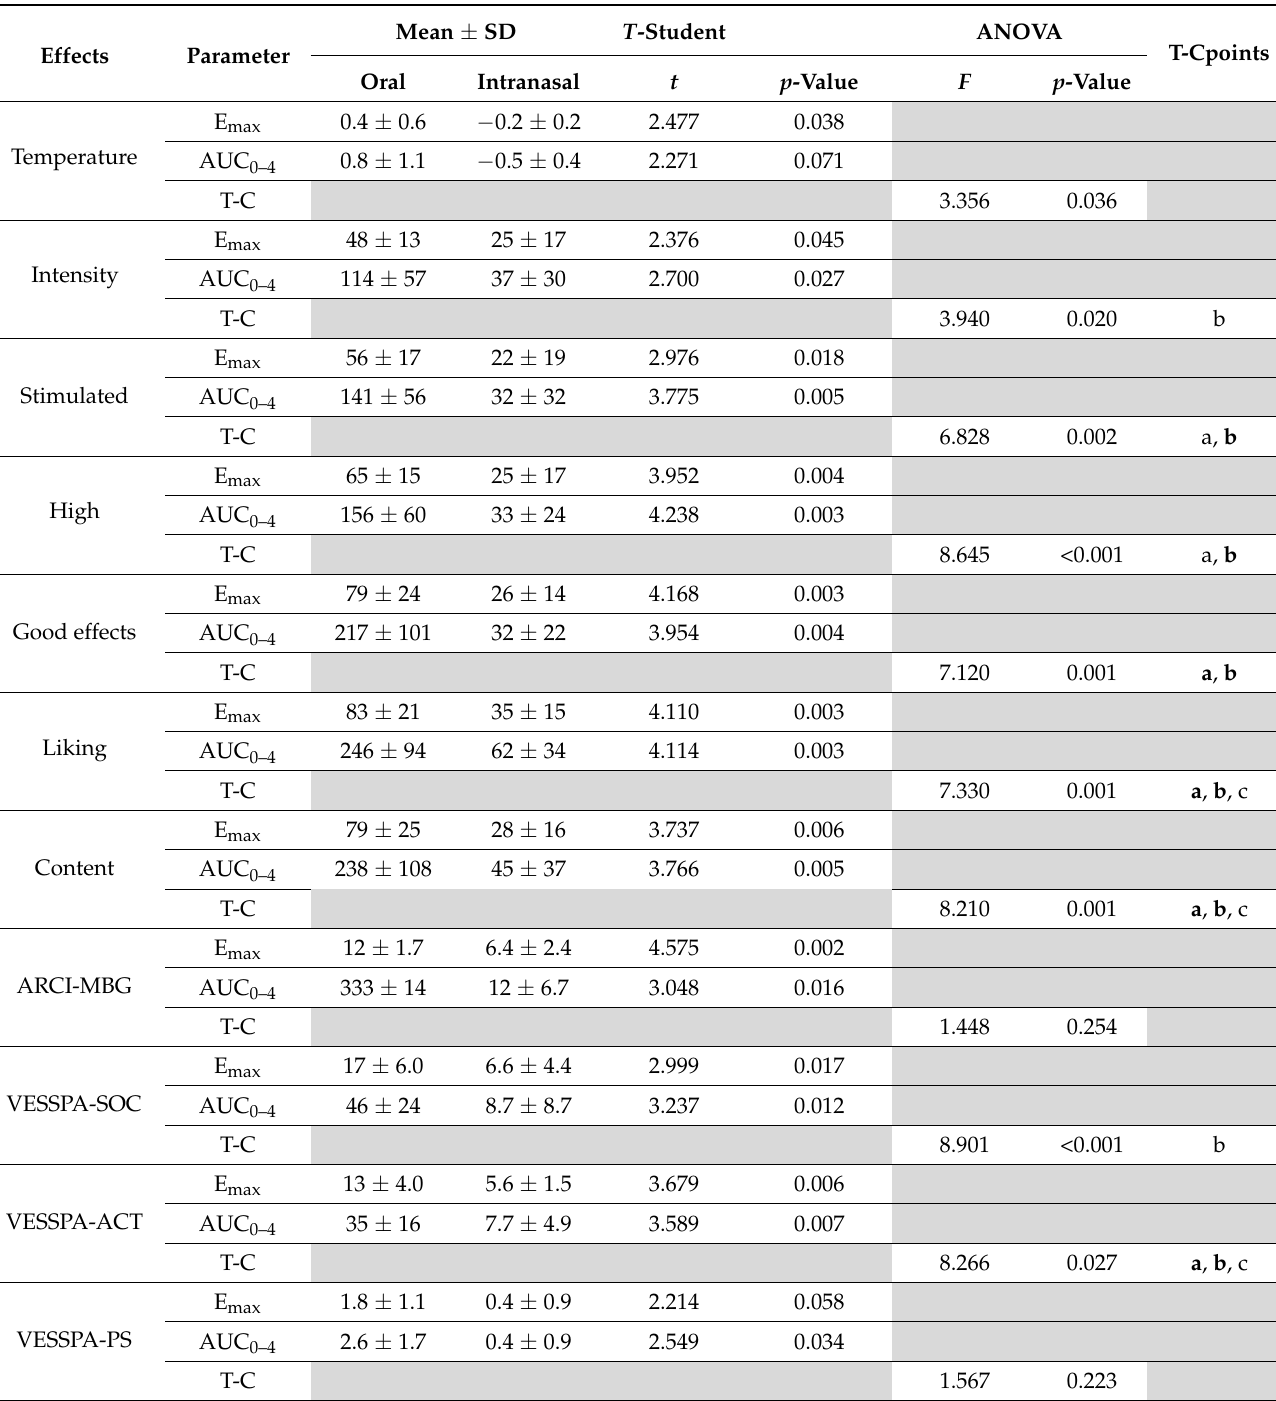
Table 1. Summary of statistically significant results on the physiological and subjective effects observed after self- administration of oral ( n = 5) and intranasal ( n = 5)